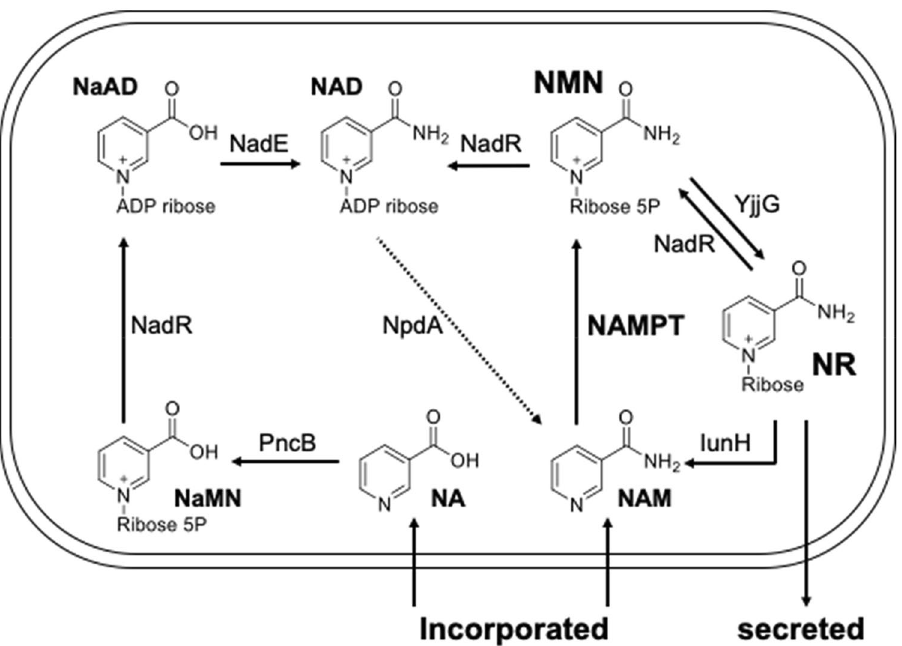
Figure 6. Salvage pathway for NAD + biosynthesis involving NMN and NR in RD012353. npdA involved in a pathway indicated by dotted arrow was pseudogenized by a 136-bp deletion in the gene. Enzymes in the figure are as follows: IunH, purine nucleosidase; NadE, NAD synthase; NadR, bifunctional NAD biosynthesis protein; NAMPT, nicotinamide phosphoribosyltransferase; PncB, nicotinate phosphoribosyltransferase; NpdA, NAD- dependent deacetylase; YjjG, 5 ′ -nucleotidase. Compounds in the figure are as follows: NA, nicotinic acid; NaAD, nicotinic acid adenine dinucleotide; NAD, nicotinamide adenine dinucleotide; NAM, nicotinamide; NaMN, nicotinic acid mononucleotide; NMN, nicotinamide mononucleotide; NR, nicotinamide